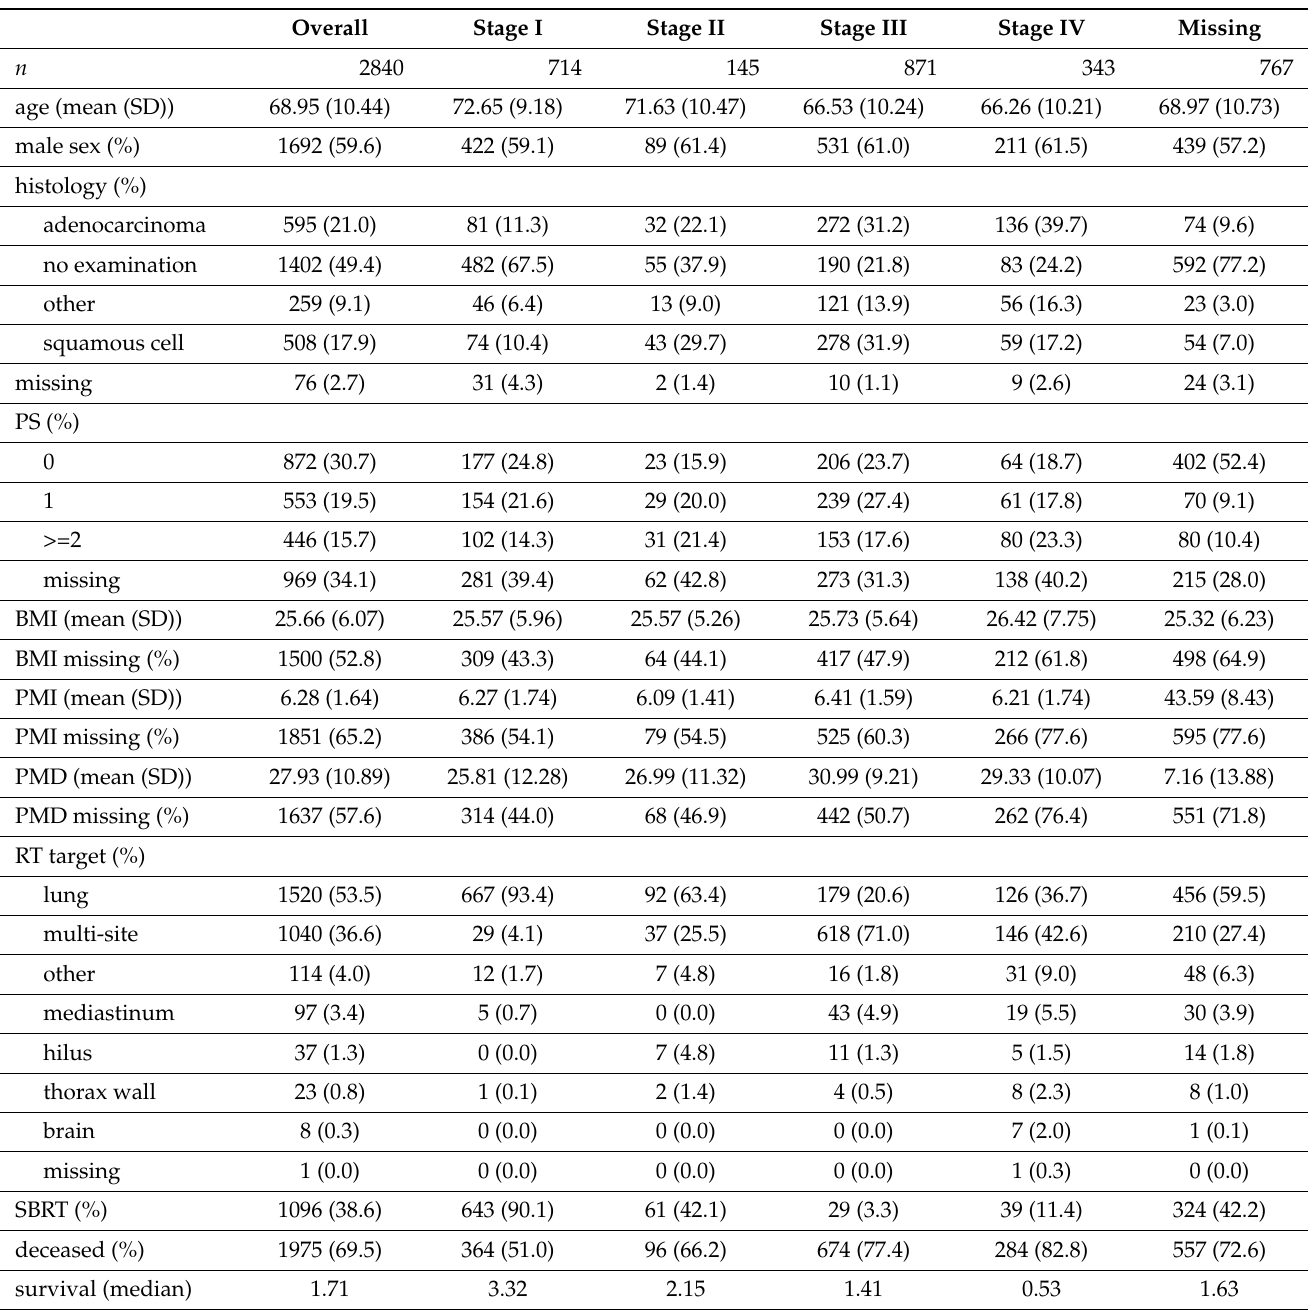
Table 1. Baseline characteristics stratified by clinical disease stage. The mean and standard deviation are calculated based on the non-missing values. The ‘other’ category for histology includes carcinoid tumors, neuro-endocrine tumors and other rare histologic subtypes. Variables age, male sex, SBRT, deceased and survival time had no missing values. A comprehensive dedicated table of radiotherapy targets is presented in the supplementary (Supplemental Tables and Figures). Median overall survival was calculated using the Kaplan–Meier method. PS: performance score, defined using the